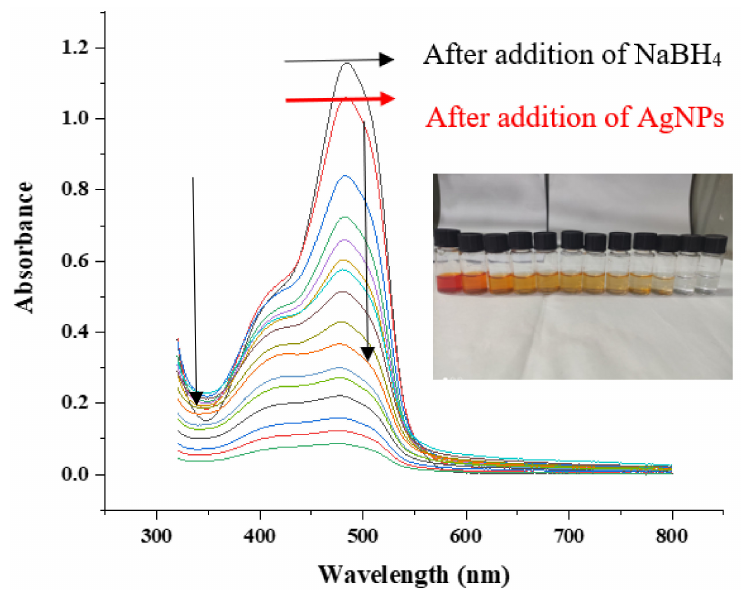
Figure 14. UV-Vis spectra of methyl orange after treating it with NaBH 4 and silver nanoparticles respectively (taken after each 4 min for an